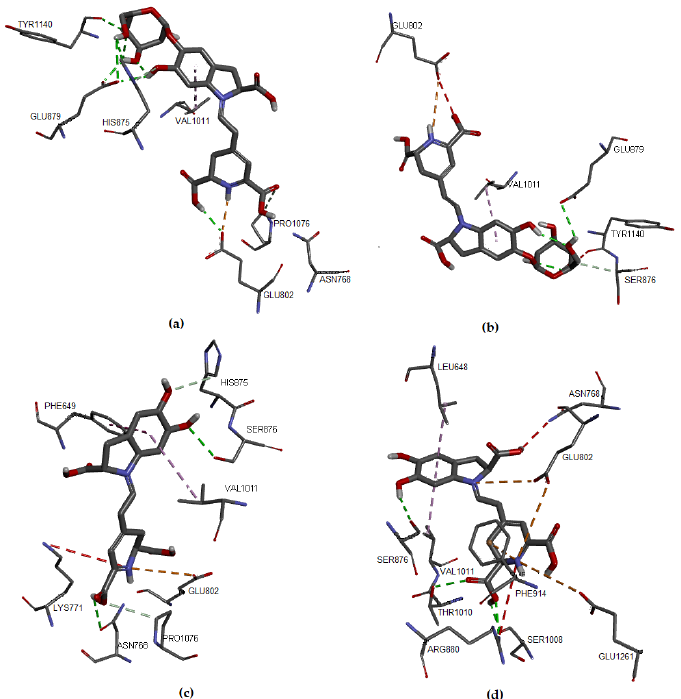
Figure 5. Molecular models of binding of compounds to active site of xanthine oxidase. A three-